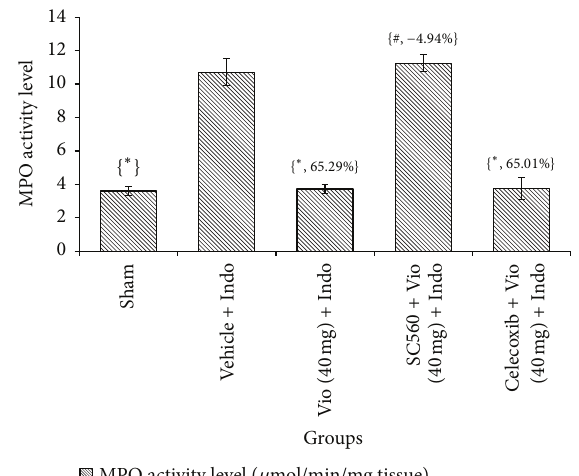
Figure 4: Effect of COX-1 and COX-2 inhibitors and violacein (40mg/kg, orally) on MPO level in indomethacin-induced ulcer. Values are mean ± SD ( 𝑛 = 6 ). ∗ 𝑃 < 0.05 compare vehicle + Indo with all the groups; # 𝑃 < 0.05 compare Vio (40mg) + Indo with SC560 (or) Celecoxib + Vio (40mg) + Indo. Indo: indomethacin; Vio: violacein; MPO: myeloperoxidase.